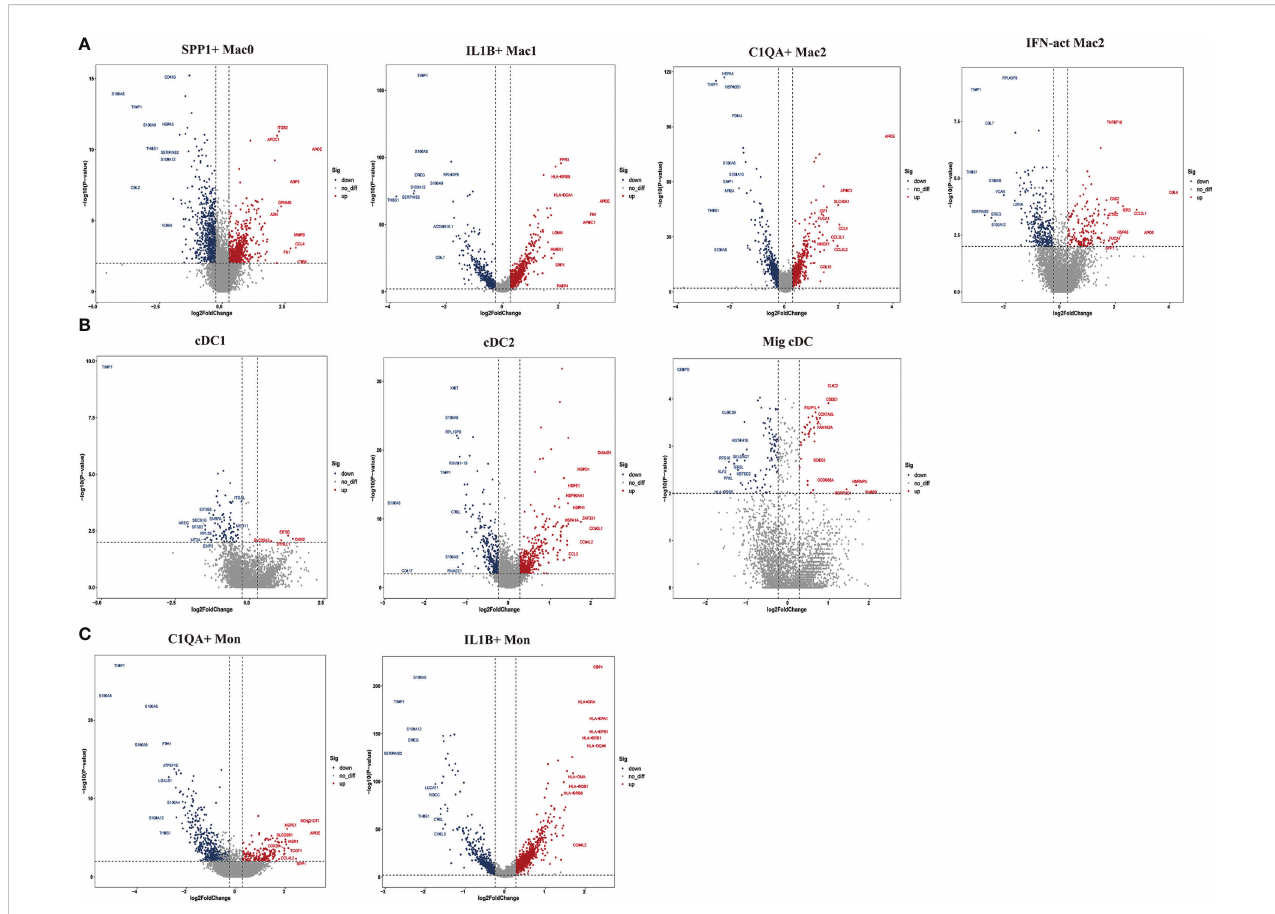
FIGURE 6 Top 10 differentially expressed genes (DEGs) of myeloid cell subclusters in HG and NG. (A) DEGs of macrophage (Mac) subclusters in HG and NG. (B) DEGs of dendritic cells (DCs) subclusters in HG and NG. (C) DEGs of monocyte (Mon) subclusters in HG and NG. HG, high stress group; NG, normal stress